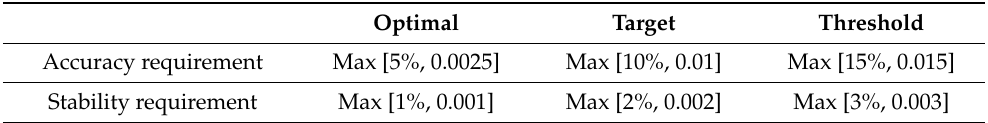
Table 6. Predefined accuracy and stability requirement levels used for SA